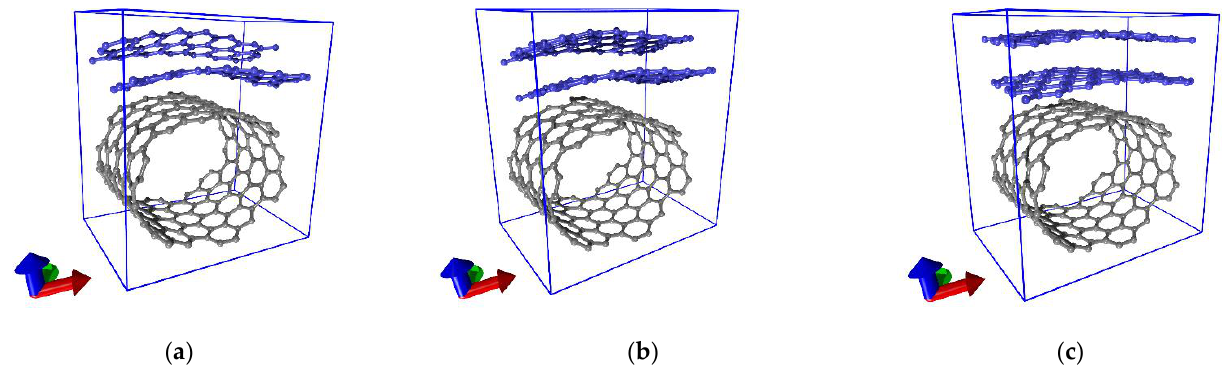
Figure 1. Topological models of supercells of hybrid films formed by bilayer graphene and single-walled carbon nanotubes (SWCNTs) (12, 6): ( a ) model V1; ( b ) model V2; ( c ) model V3. Hereinafter, the red axis corresponds to the X axis, the green axis corresponds to the Y axis, and the blue axis corresponds to the Z axis.